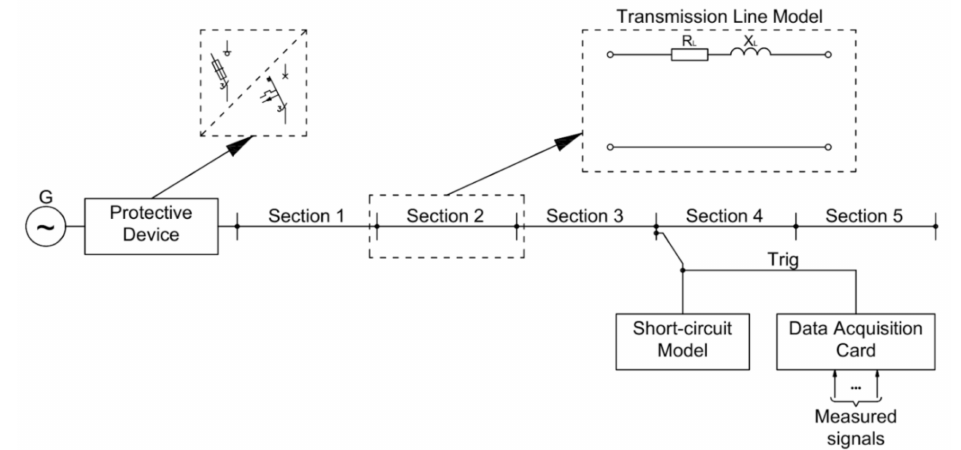
Figure 4. The laboratory system used to tests of the protective devices.